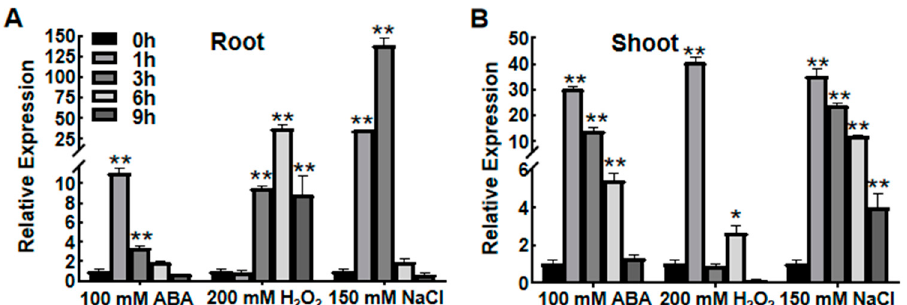
Figure 1. Expression profiles of OsASR6 . Inducible expression pattern of OsASR6 in ( A ) the roots and ( B ) the shoot under ABA, H 2 O 2 , and NaCl stresses treatment. Rice Actin1 was used as an internal control for qRT-PCR analysis. Asterisks indicate significant difference compared to the transcription level of 0 hr groups. Three independent experiments were performed. Data represent means ± SD. * p < 0.05, ** p < 0.01.